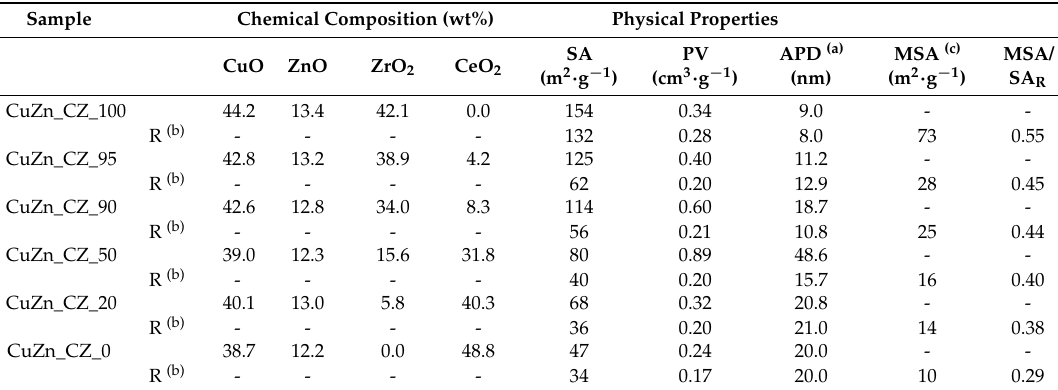
Table 1. List of catalytic system based on Cu-Zn oxides